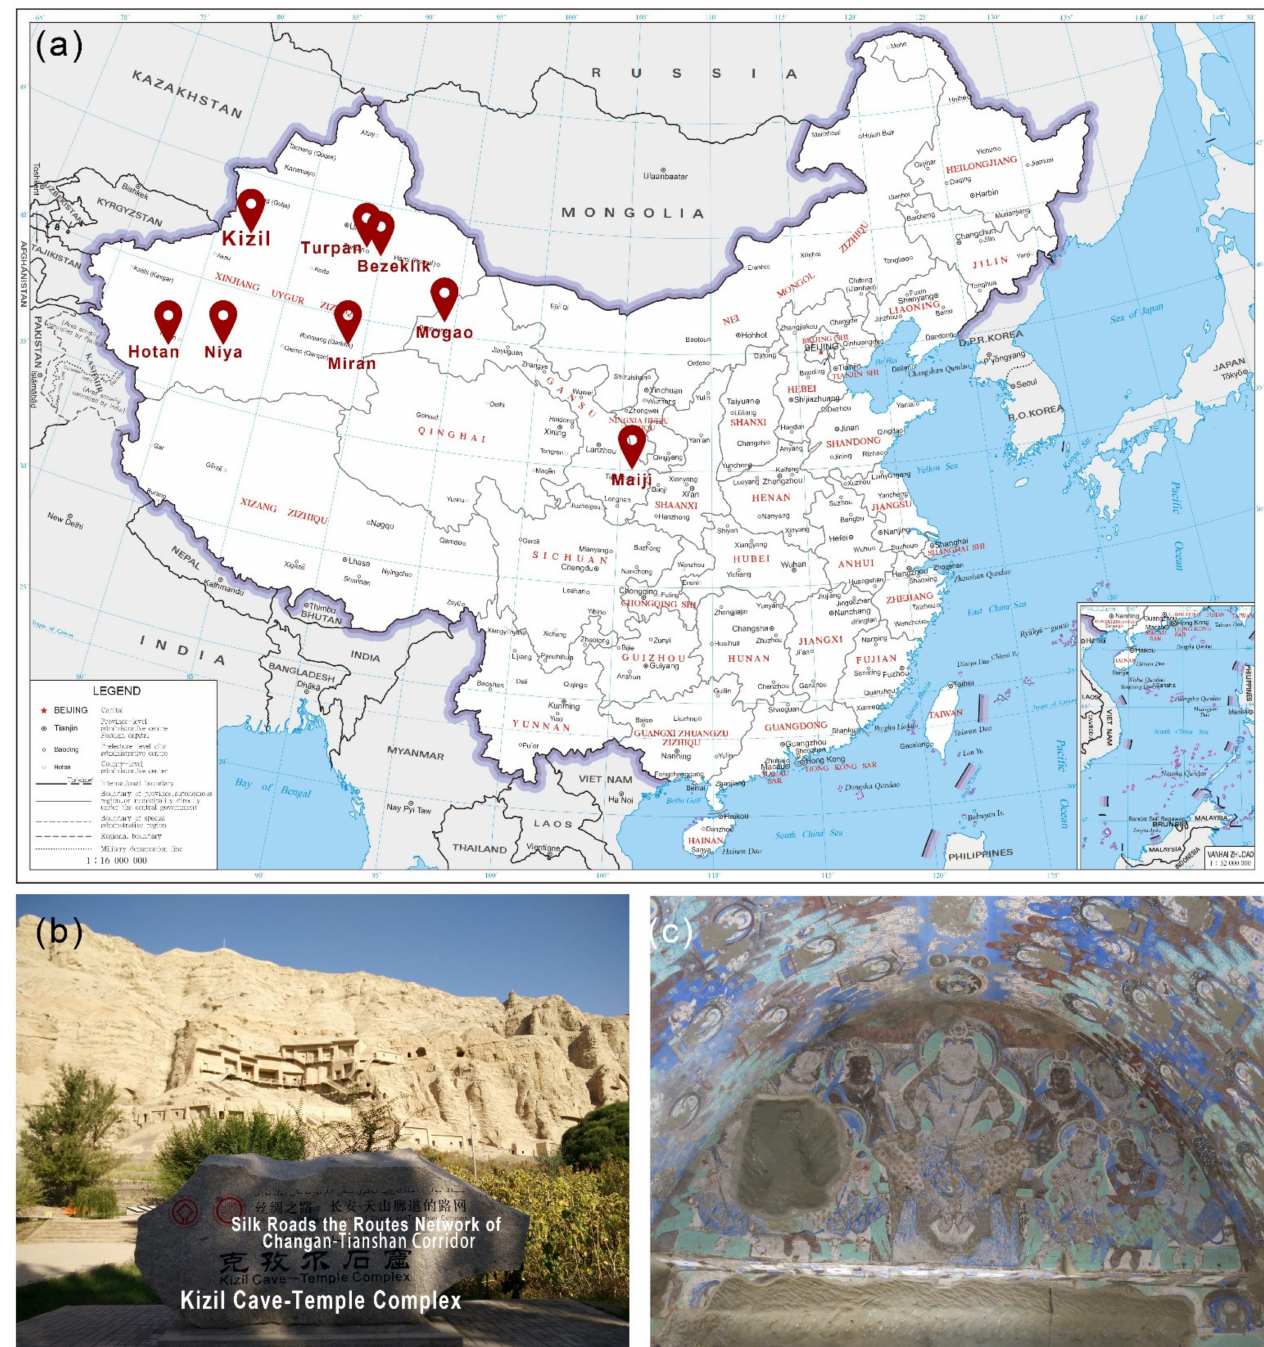
Figure 1. ( a ) The location of Kizil grottoes and important ancient Buddhism grottoes along the silk road in China; ( b ) the front view of Kizil grottoes; ( c ) a mural painting in Kizil grottoes (Cave No. 171, fifth–seventh century